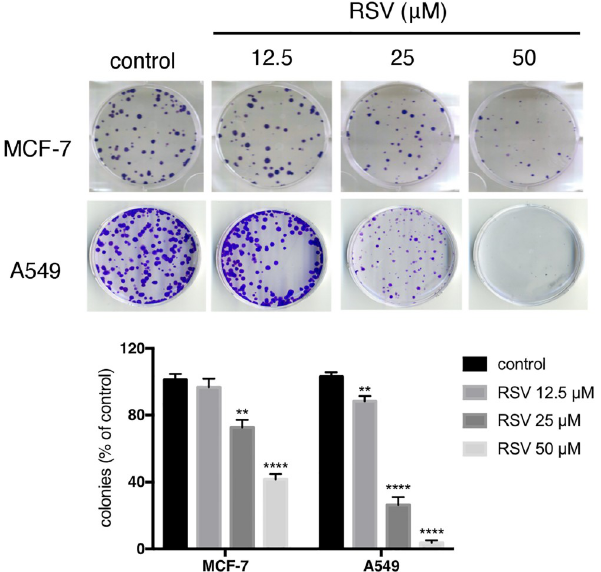
Fig 1. The inhibition of the growth of MCF-7 and A549 cell lines in a dose-dependent manner by RSV. Clonogenic survival assays of MCF-7 and A549 cells (500 cells/well) were seeded in a 6-well dish and treated with the indicated concentrations of resveratrol (RSV). After 2 weeks of incubation, the number of MCF-7 and A549 cell-derived colonies decreases with increased RSV dose. The MCF-7 or A549 cell clones (500 cells/well) were seeded in a 6-well dish. After 12 days of incubation, the cells were stained with crystal violet and counted by phase-contrast microscopy. Bars represent means ± standard deviation (s.d.), and asterisks denote a statistically significant difference. Data are representative of at least three independent experiments performed in triplicates. �� , ���� P � 0.05 based on Student’s t- test.